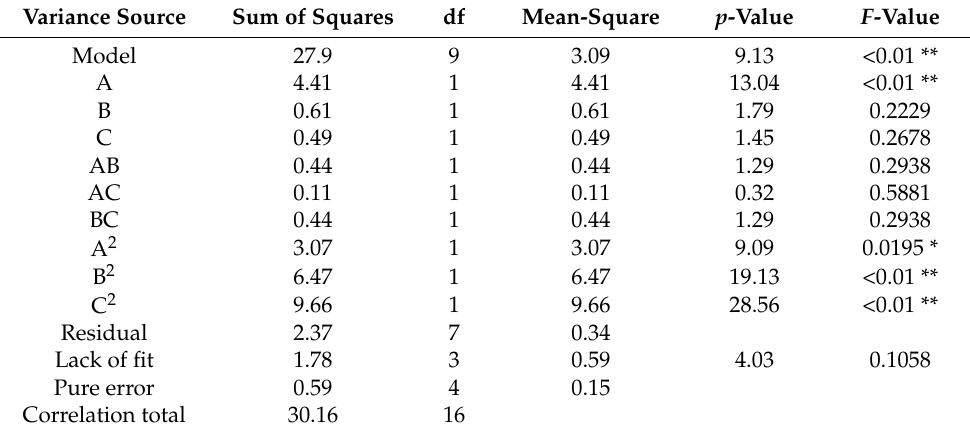
Table 2. The ANOVA of RSM